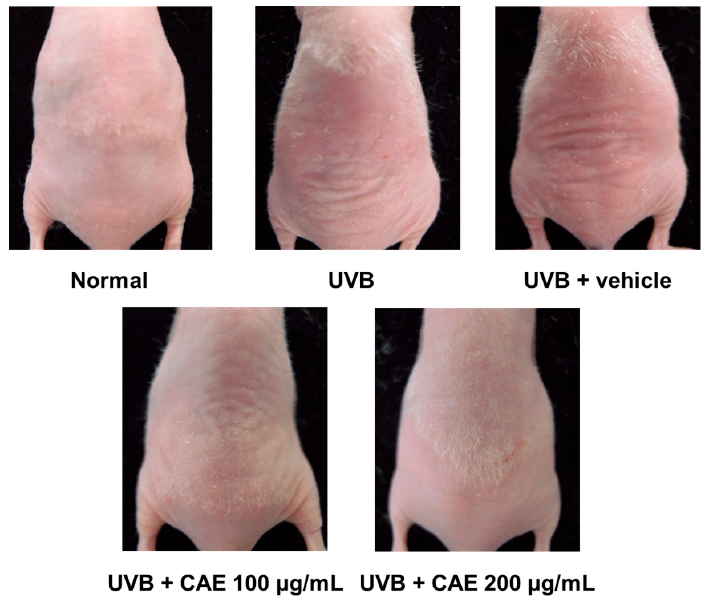
Figure 13. Photographs of wrinkles induced by UVB irradiation and the effect of topical application of CAE.